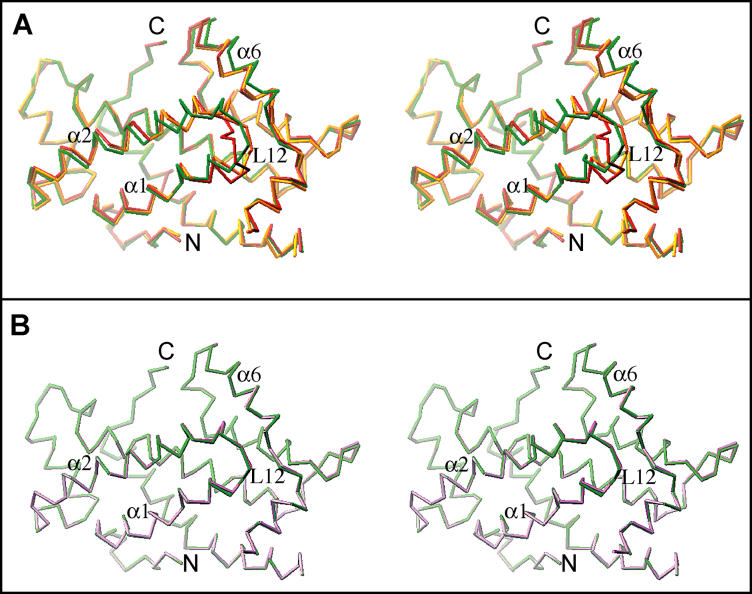
Stereo Superposition of the Conformational States of GLTP(A) The GLTP backbone is shown in red, gold, or green Cα representation for apo-GLTP and GLTP complexes with n-hexyl-β-d-glucoside and 24:1 GalCer, respectively.(B) The GLTP Cα backbone is shown in green and lavender for GLTP complexes with 24:1 GalCer and 18:1 LacCer, respectively.